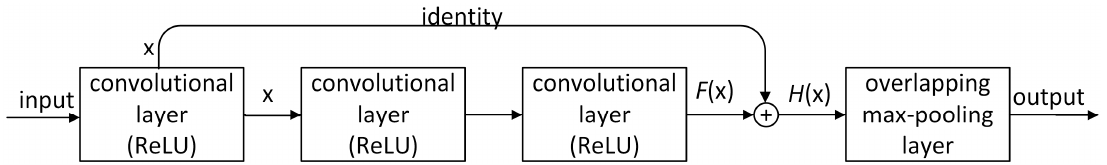
Figure 7. Residual block used in MRCNN. The first convolutional layer outputs its learned features x, which are sent to the second and third convolutional layer for learning residual features F (x). F (x) and x are then fused using a sum operation to form the target features H (x).